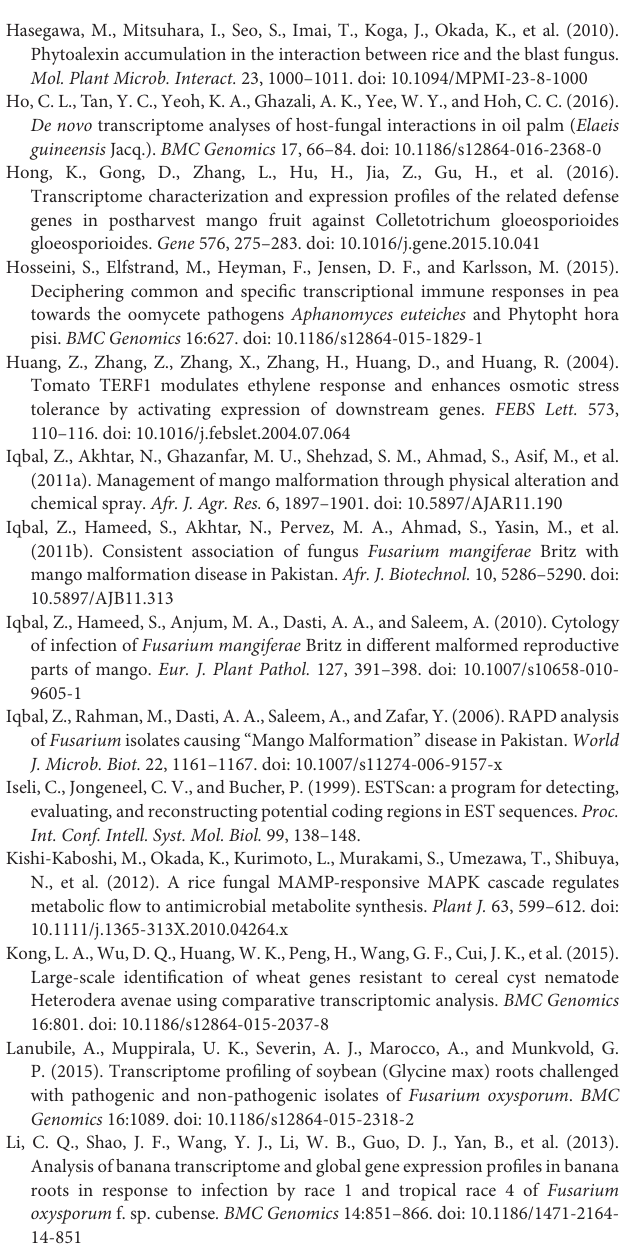
Figure S1 | Frequency distribution of Contig lengths in Illumina HiSeq TM 2000 sequencing data.